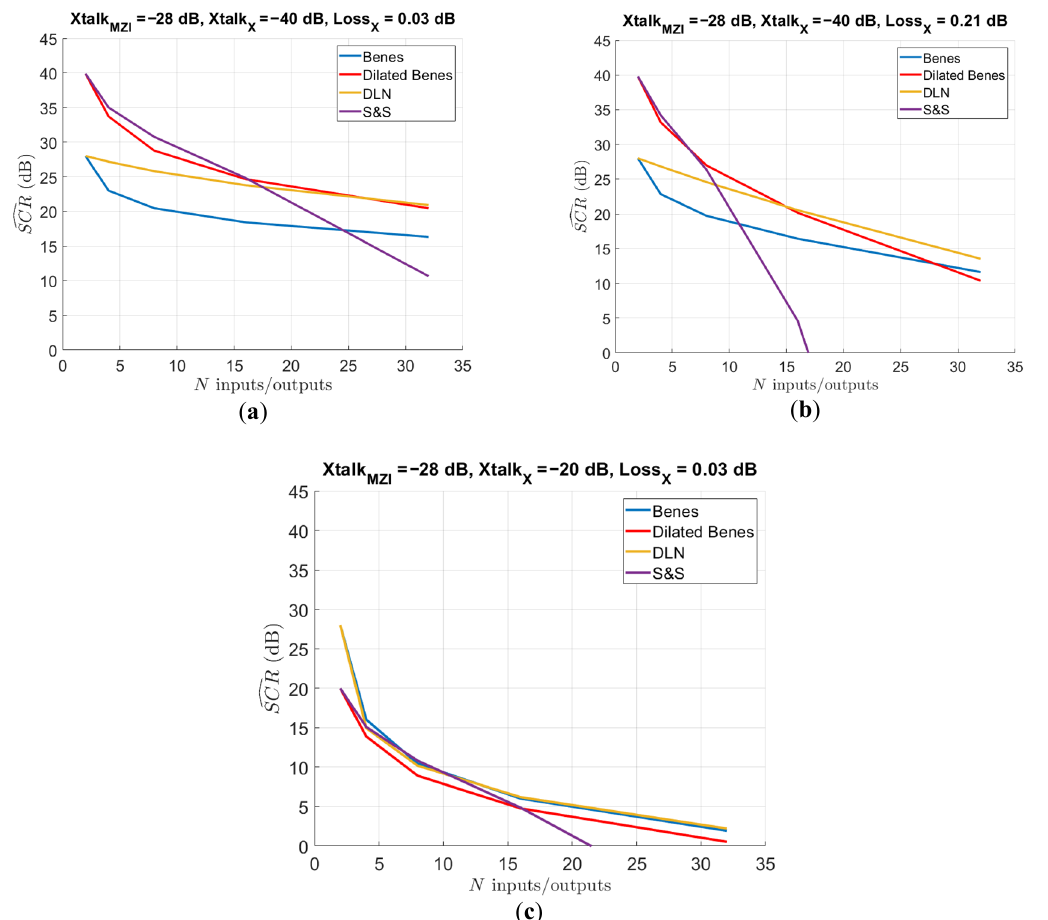
Figure 7. ˆ SCR of the four topologies using the state-of-the-art loss and crossing values ( a ), a significant crossing loss Loss X = 0.21 dB ( b ) and using a non-optimized crossing crosstalk Xtalk X = − 20 dB ( c ). Table 4. State-of-the-art loss and crosstalk of MZI and waveguide crossing. Metric Value Ref. Waveguide crossing loss ( Loss X